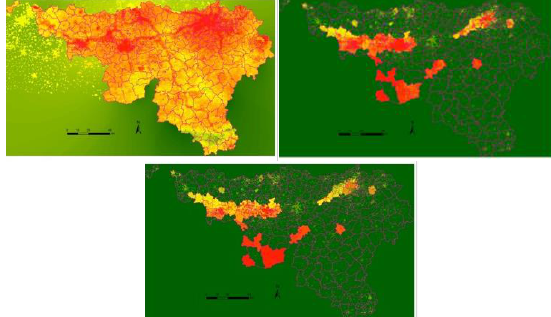
Figure 6. a, b and c: pollutions (a), populations (b) criteria and (c) health risk model related to environment in